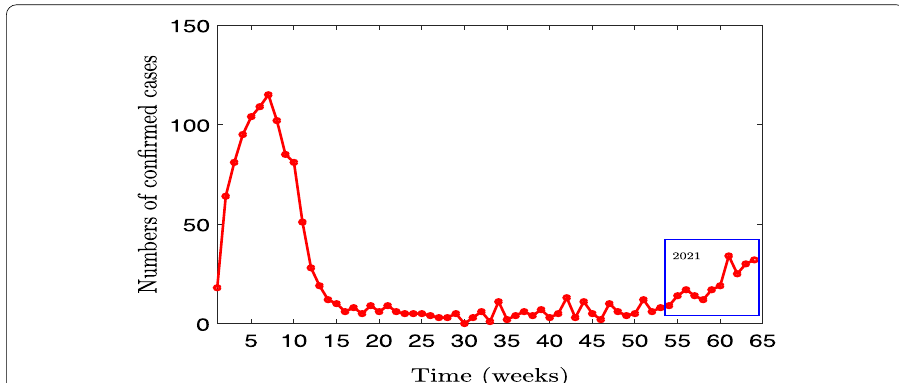
Fig. 3 Weekly reported number of confirmed Lassa fever cases in Nigeria from first week January 2020 to eleventh week in 2021, obtained from NCDC database